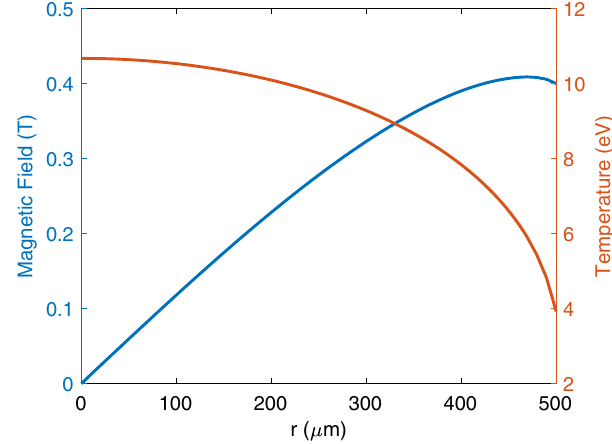
FIG. 4. Calculated profiles of the magnetic field (blue curve) and plasma temperature (red curve) along the capillary radius.